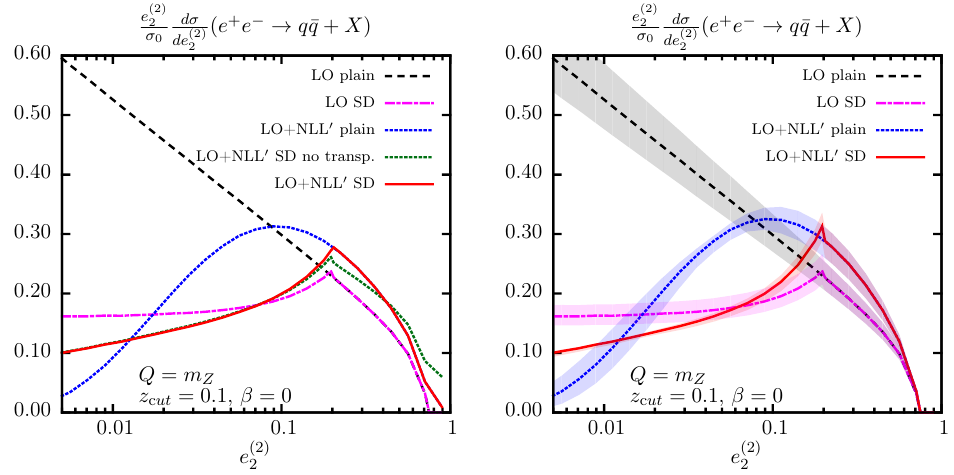
(black dashed) and soft- 2 (blue 2